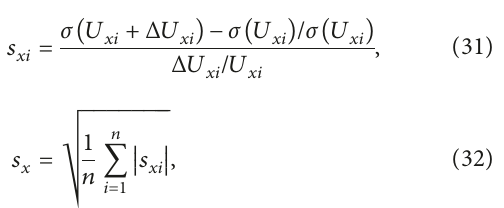
Figure 12: The vibration response sensitivity: (a) the wheelchair body RMS acceleration sensitivity s celeration sensitivity s € z ; (c) the TDD RMS sensitivity s f 2